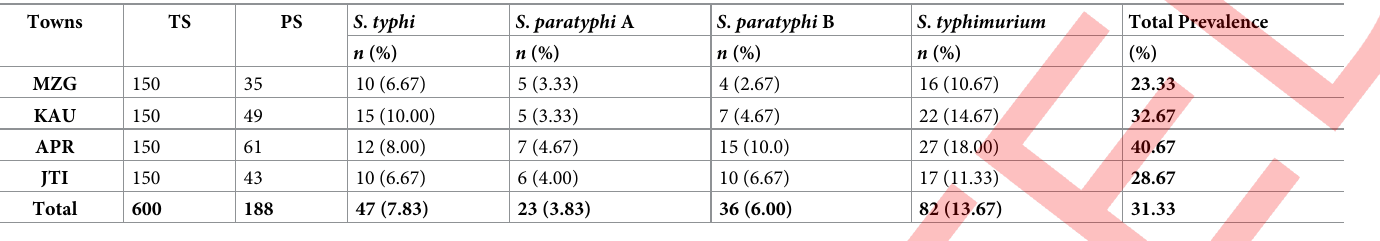
Table 6. Prevalence (%) of Salmonella spp. isolated from raw milk and environment samples in dairy farms from district Muzaffargarh .